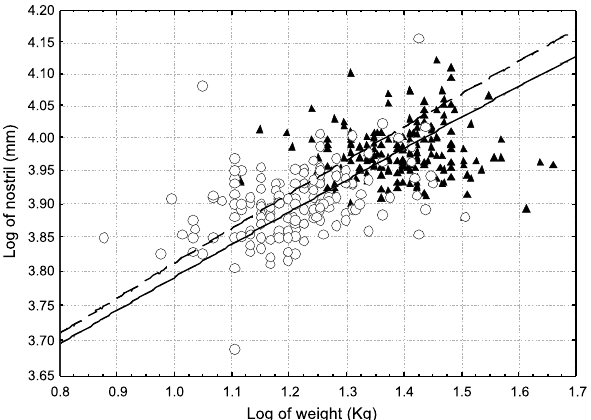
Figure 1. Nostril length against mass (log transformed) for male e and female Coscorobas. Scaling lines are plotted for both sexes using RMA regression (females: y = 3.3+0.512*x, males: y = 3.31+0.481*x). The slopes and elevations were not different be- tween sexes (Tables II and III). ( (cid:99) ) Females, ( (cid:83) ) males.